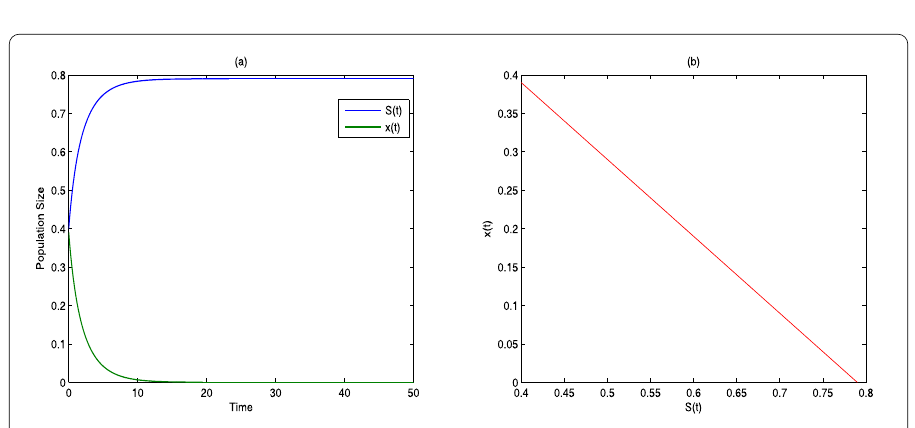
Figure 5 The time series and portrait phase of model (4.3) when α = 0. ( a ) stands for the time series of S ( t ) and x ( t ); ( b ) stands for the portrait phase.